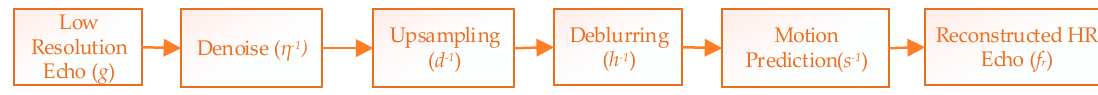
Figure 2. Reconstruction process of low-resolution (LR) echo.